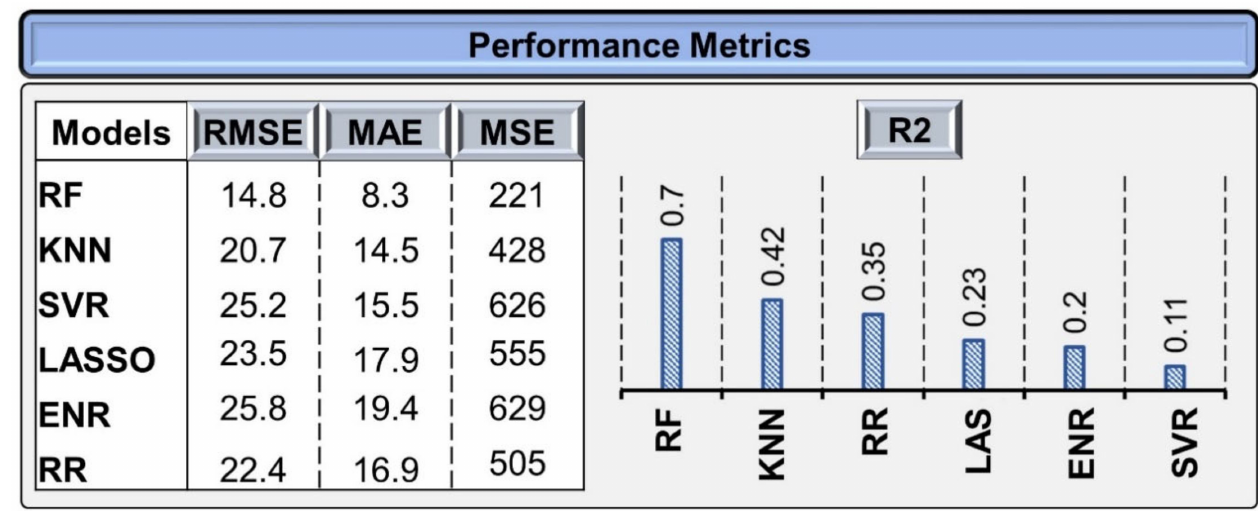
Figure 4. Performance metrics of the models employed.